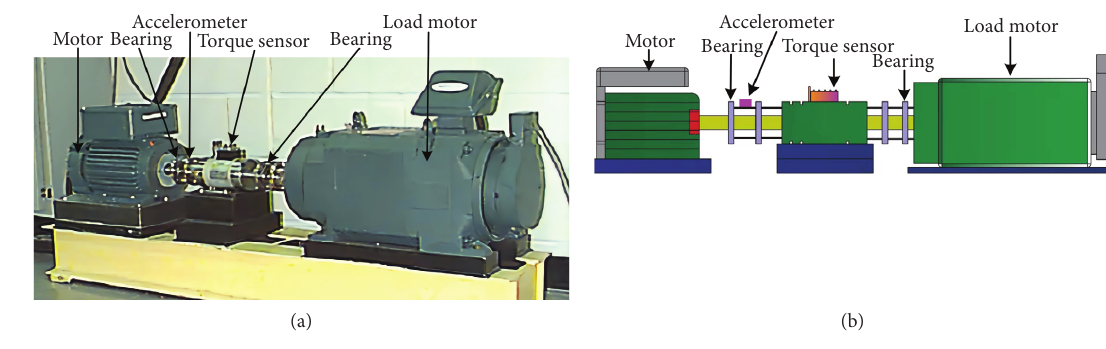
Figure 4: Bearing test bench. (a) Overview. (b) Diagram.